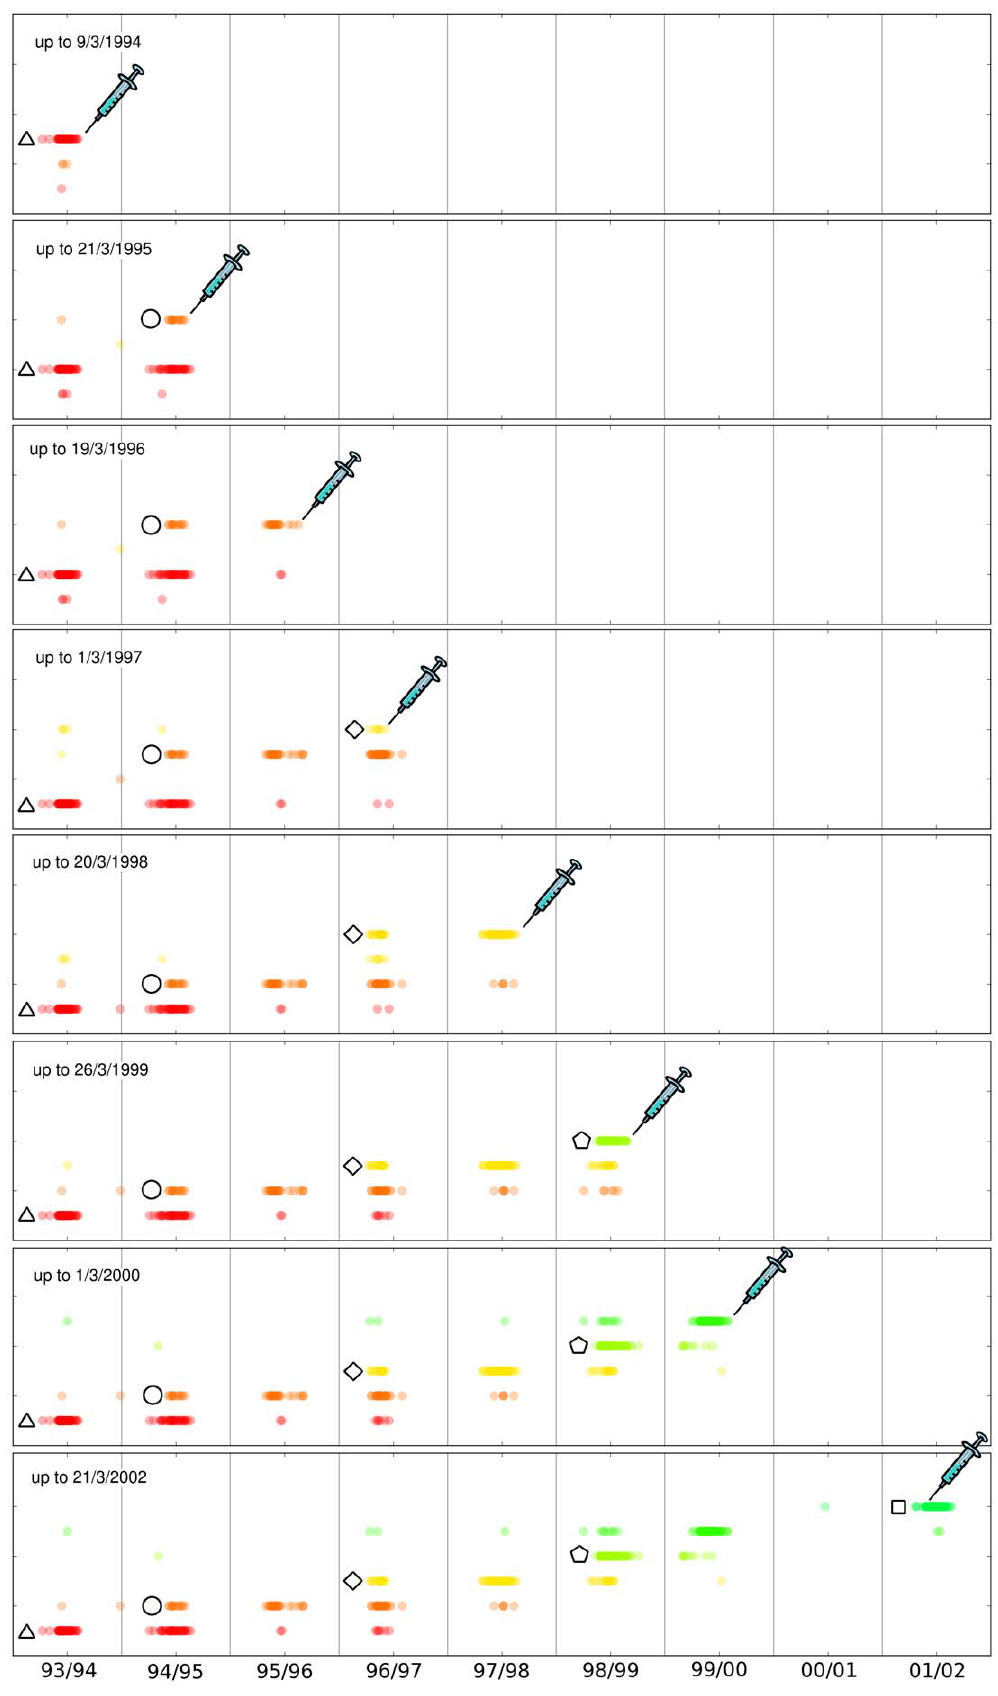
Figure 4. Changing the time window. Rohlin analysis during years. Clusters structure is robust under a sampling increase, and buds appeared during seasons correctly reveal the future circulating strains, as indicated by the syringe. doi:10.1371/journal.pone.0027924.g004 PLoS ONE |